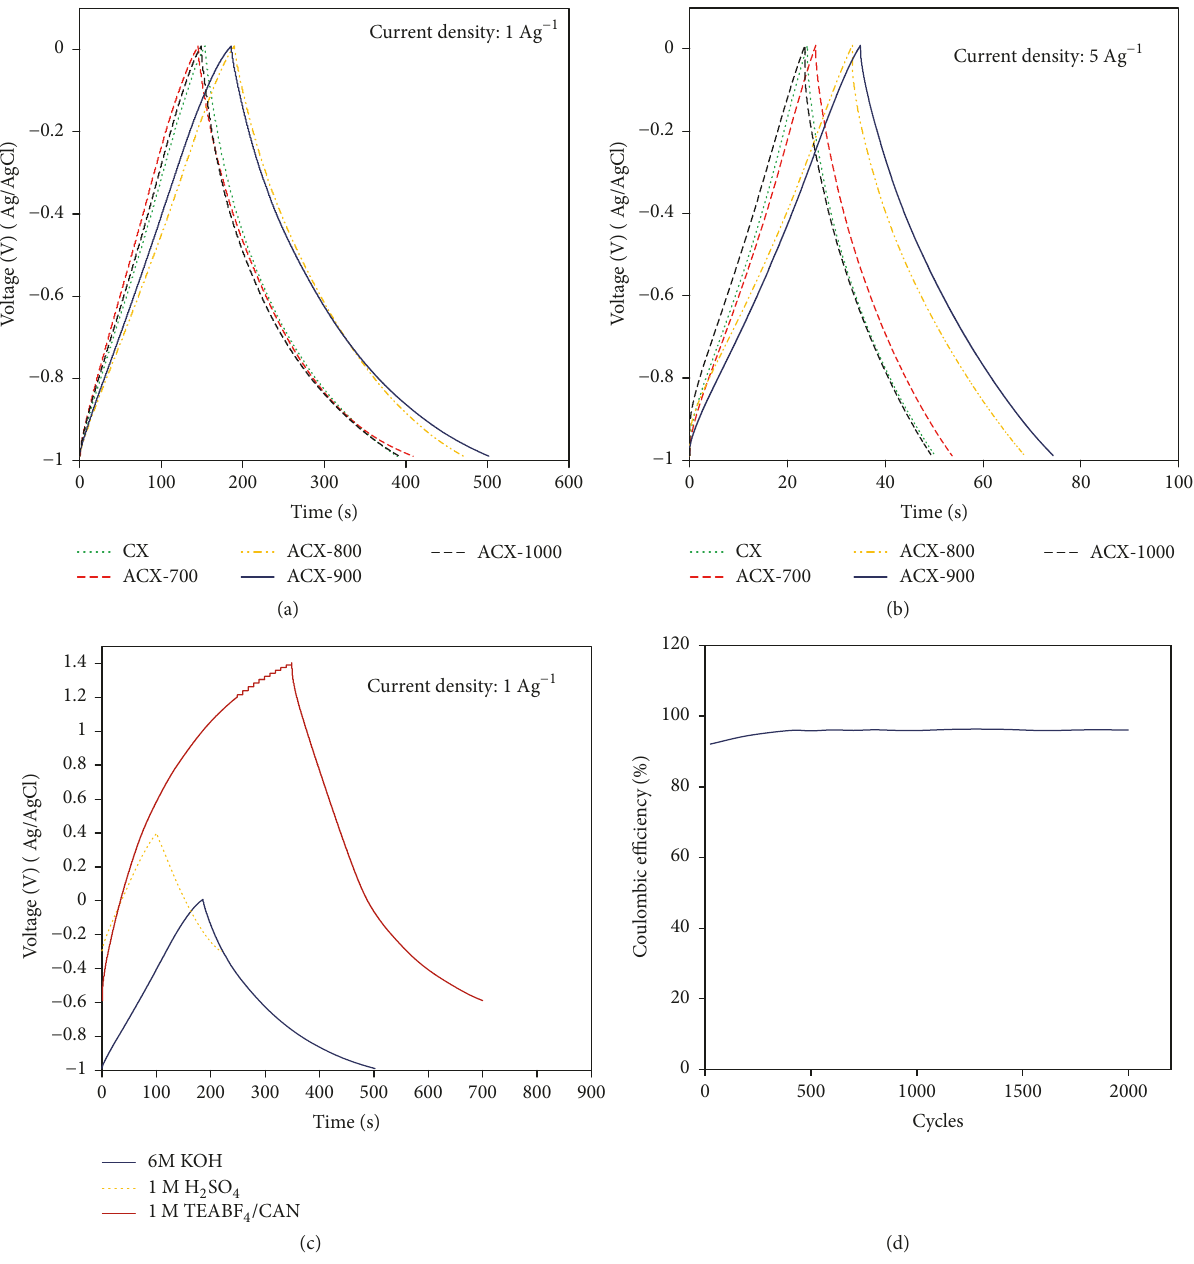
Figure 7: Charge/discharge curve of the CX and ACX electrodes at current densities of (a) 1Ag −1 and (b) 5 Ag −1 in 6M KOH electrolyte solution; of ACX-900 electrode at current densities of 1 Ag −1 in all electrolyte solutions (c) and its Coulombic efficiency (d).